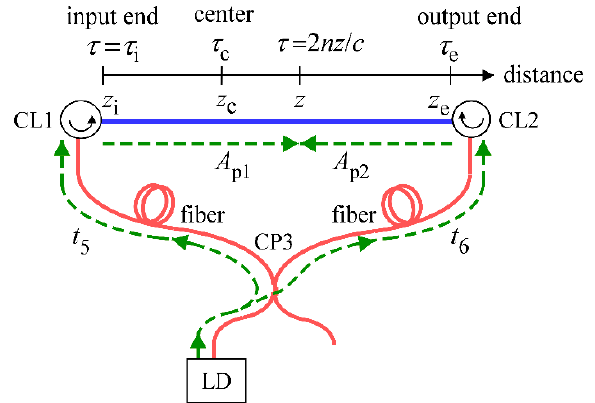
Figure 3. Schematic of the propagation (highlighted in green) of counter-propagating pump light waves from the LD in the fiber loop. t 5 and t 6 are the propagation times of the pump light waves from the LD to optical circulators CL1 and CL2, respectively. z is a coordinate of the distance along the fiber under test highlighted in blue and the origin of the distance is positioned at the point where the produced reflection has the same optical path length as the LO light at the balanced mixer. The input and output ends of the fiber were assumed to be located at z i and z e , respectively. τ is the round-trip time from the origin to any position at z as defined by τ = 2 nz / c , where n is the refractive index of the fiber and c is the velocity of light in a vacuum. Similarly, τ i and τ e are de- fined as τ i = 2 nz i / c and τ e = 2 nz e / c . A p1 and A p2 are the complex amplitudes of the electric fields of the pump light waves propagating in the clockwise and counterclockwise directions, respectively. The center of pumping is defined by the position where the optical path lengths of the two pump light waves are equal in the optical fiber loop. CL1 and CL2: Optical circulators, CP3: Fiber cou- pler, LD: Laser diode.